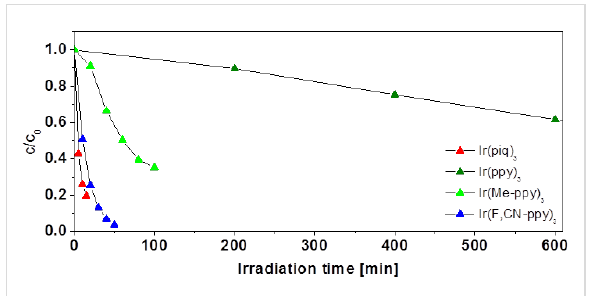
Figure 2: Photodegradation of the different compounds in toluene under ambient atmosphere. Plotted is the ratio between the remaining and initial concentrations for the respective compound against the ir- radiation